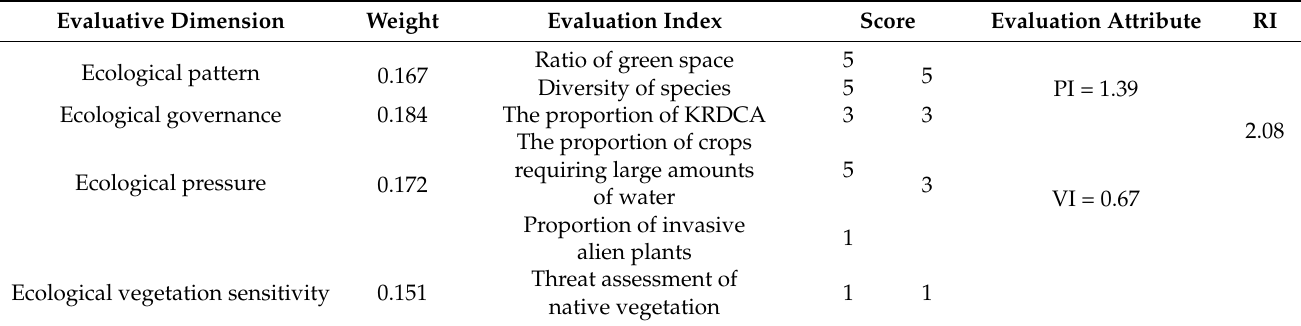
Table 3. Assessment results of ecological resilience in Fanhua